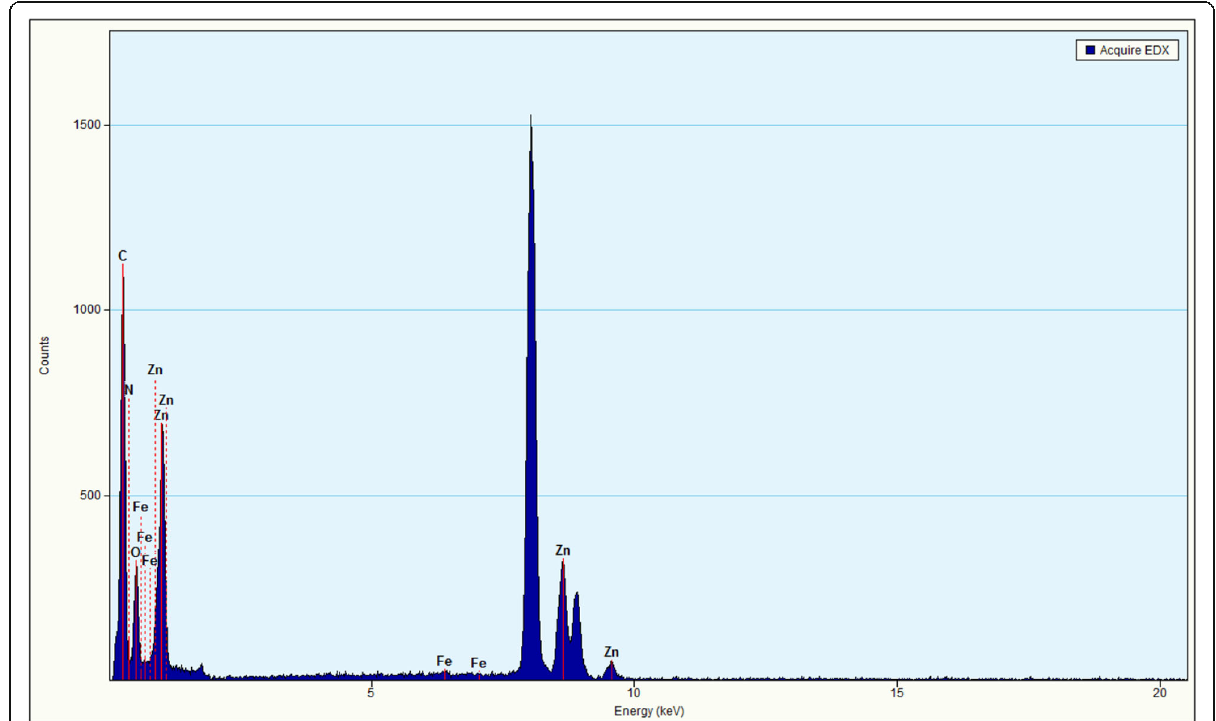
Fig. 3 EDX of ZnO/Fe 3 O 4 /g-C 3 N 4